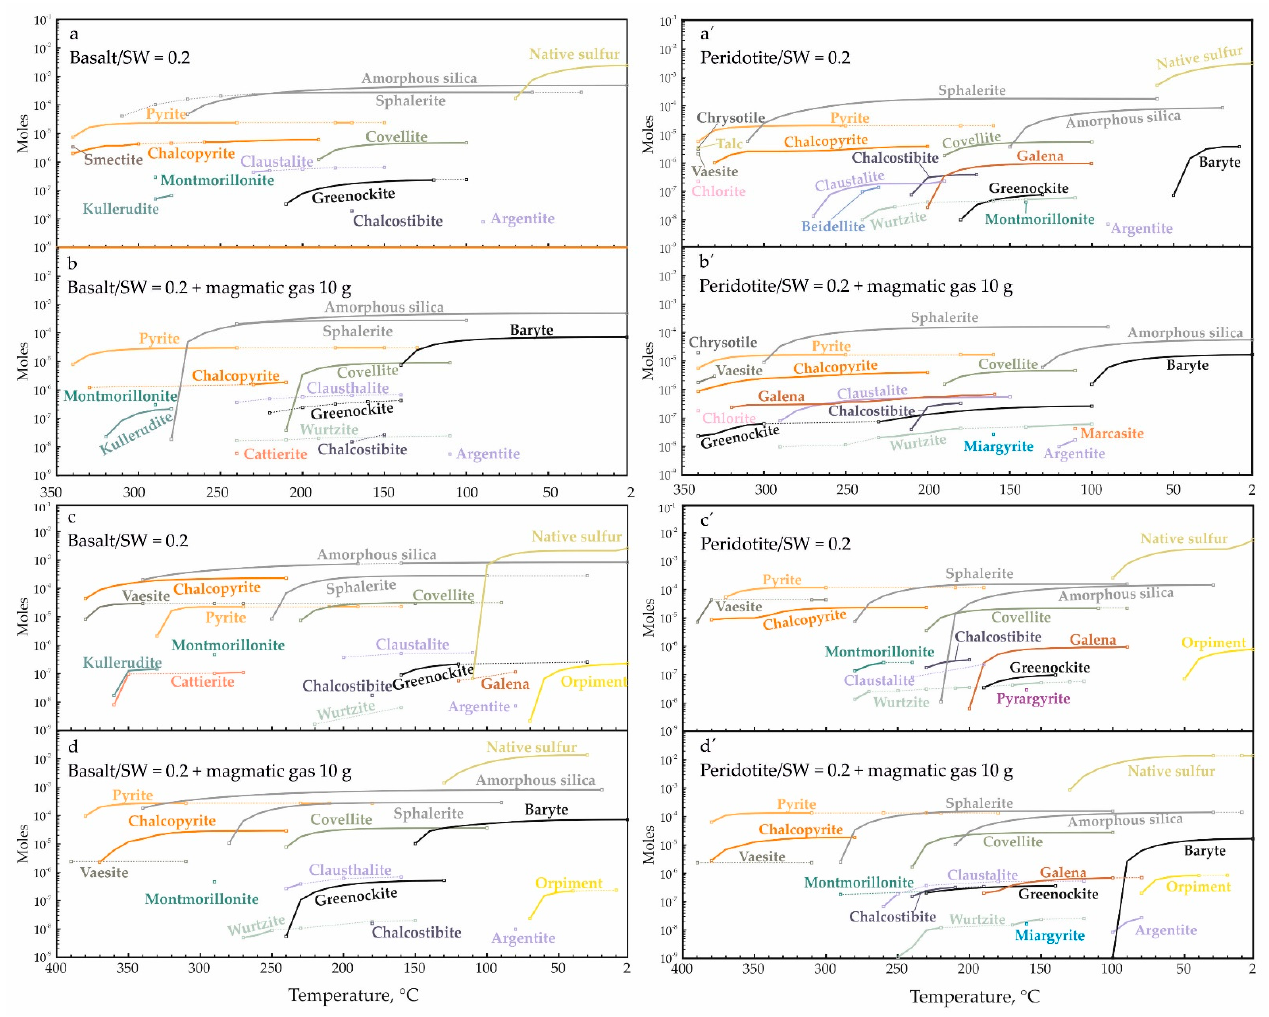
Figure 11. Amount of minerals precipitated from the solution reacted with basalt ( a – d ) and peridotite ( a ’– d’ ) at temperatures from 350 ( a , a’ , b , b’ ) and 400 ( c , c’ , d , d’ ) to 2 °C with a step of 10 °C. The plot lines reflect the accumulating total. The discontinuous precipitation or the absence of minerals in a temperature range are marked by solid and dotted lines, respectively.